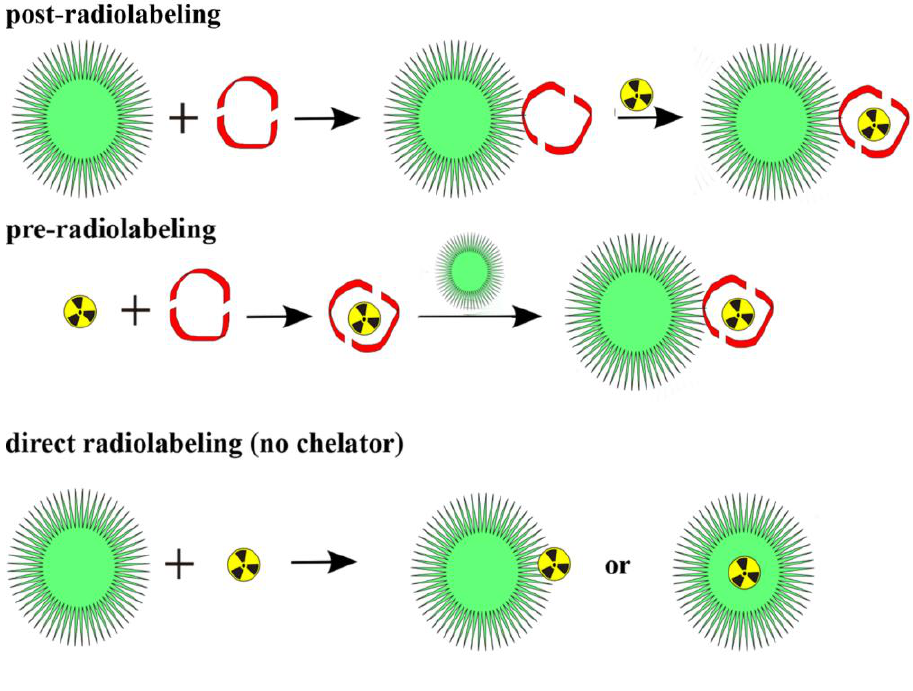
Figure 5. Three general radiolabeling approaches using metallic radionuclides and